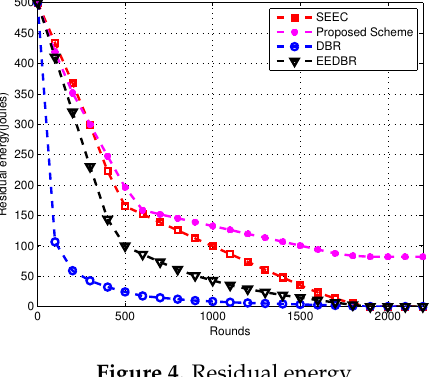
Figure 4. Residual energy